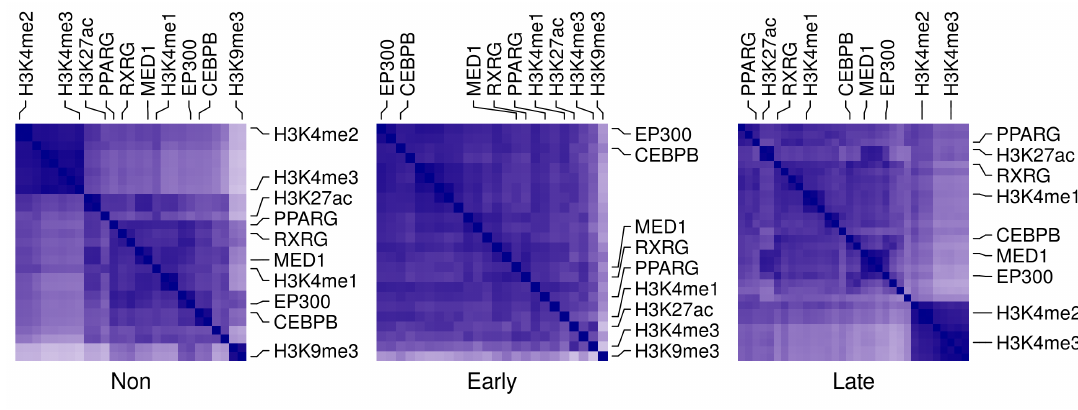
Figure 7. Correlation in occupancy between adipogenic transcription factors and histone markers on autophagy genes at different stages. The total number of reads in peaks of each ChIP-Seq sample (n = 84) was used to represent the factor/histone marker occupancy. Pearson’s correlation coefficient (PCC) was calculated for each pair of samples. The PCC value is between 0 (white) and 1 (blue). Samples were categorized by differentiation stage; non, early or late in that order.